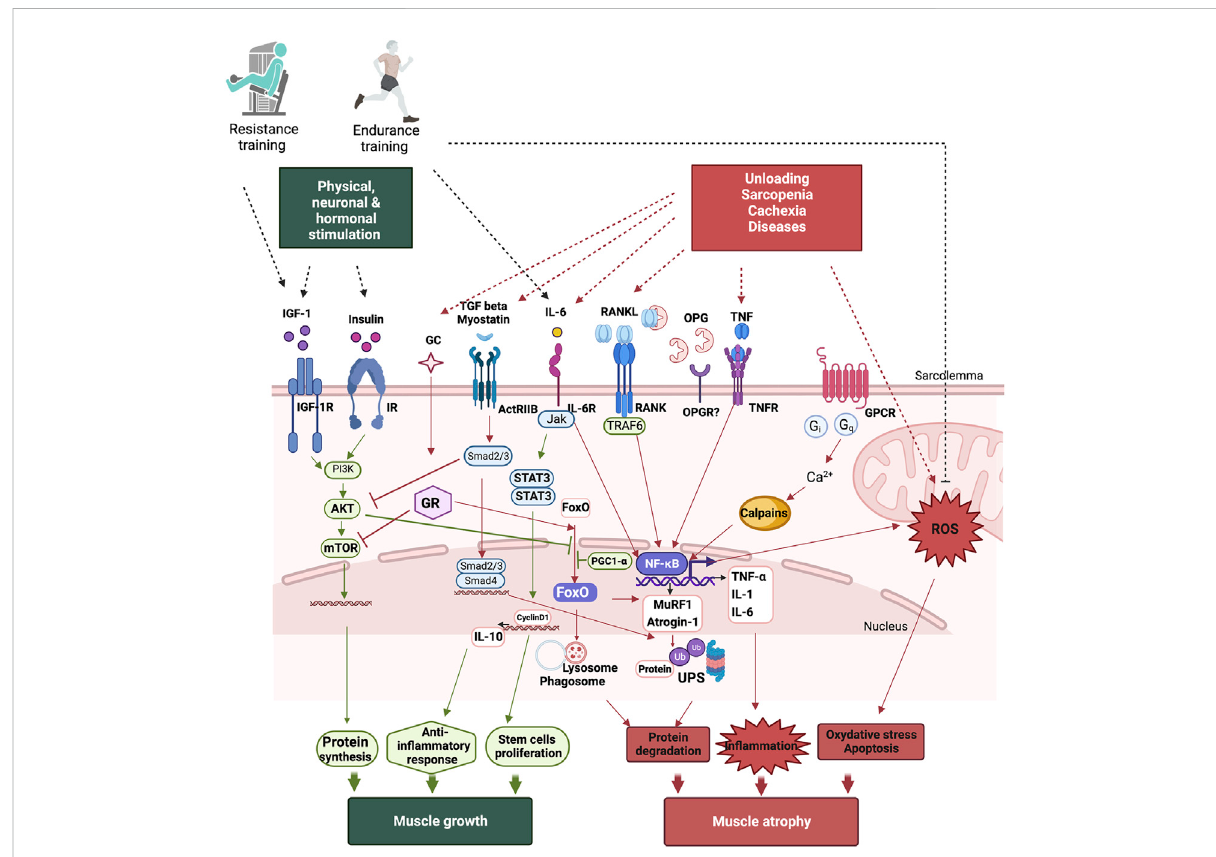
Signaling pathways leading to protein turnover in skeletal muscles. Muscle growth occurs following physical, neuronal, and hormonal stimulations. While a gain of muscle mass is mainly associated with resistance training, endurance training also improves muscle function by improving mitochondrial function, reducing oxidative stress, and modulating in fl ammation. Following unloading, age-related muscle wasting, sarcopenia, or diseases such as cachexia induces muscle atrophy. Muscle atrophy occurs as result of an increase in protein degradation, in fl ammation,oxidativestress,andapoptosis.ThemainpathwayinvolvedinproteinsynthesisisthePI3K/Akt/mTORpathway,whichisactivatedboth by growth hormone (GH) and insulin-like growth factor IGF-1. Protein breakdown involves the activation of the ubiquitin-proteasome system (UPS) and the autophagy-lysosome system (ALS), which are mainly regulated by FoxOs and NF- κ B, leading to muscle atrophy. NF- κ B also inceases pro- in fl ammatory cytokine production and ROS, accentuating muscle loss. TGF beta, myostatin, RANKL, TNF- α , and IL-6 induce NF- κ B activation. However, IL-6 can act as both a pro- and an anti-in fl ammatory cytokine as it induces anti-in fl ammatory cytokine IL-10 production and is mainly involved in stem cell proliferation leading to muscle